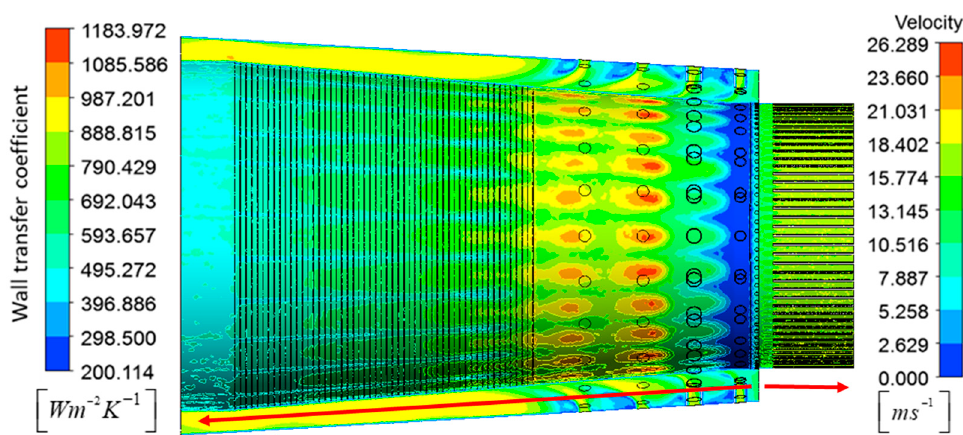
Figure 9. Wall heat transfer coefficient and velocity distribution on the outer CL from model 2 using the boundary condition in Table 2.